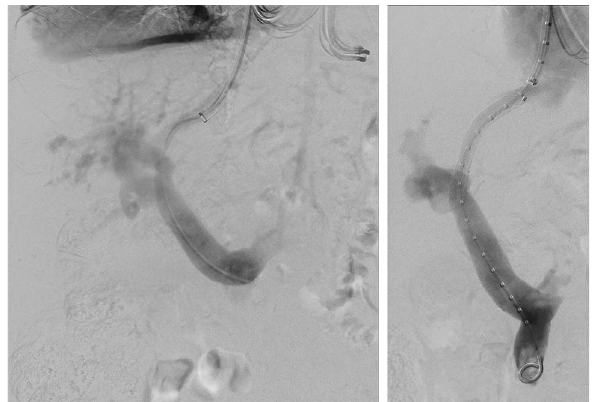
Figure 3. TIPS insertion. The initial TIPS in a 79-year-old male patient was placed from the middle hepatic vein to the left portal vein due to refractory ascites with esophageal varices (Gore Viatorr stent; 8 mm diameter; 60 × 20 mm).